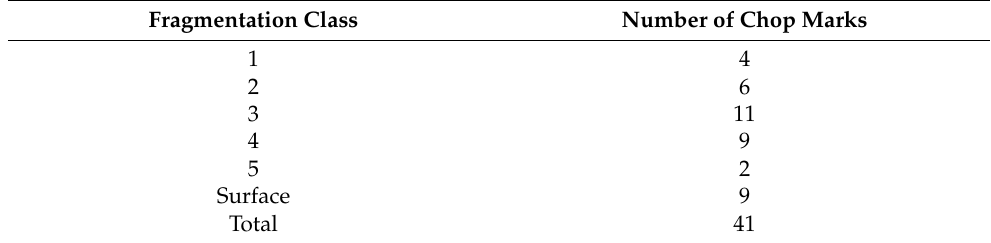
Table 6. The frequency distribution of experimental copper axe chop marks by Fragmentation Class.